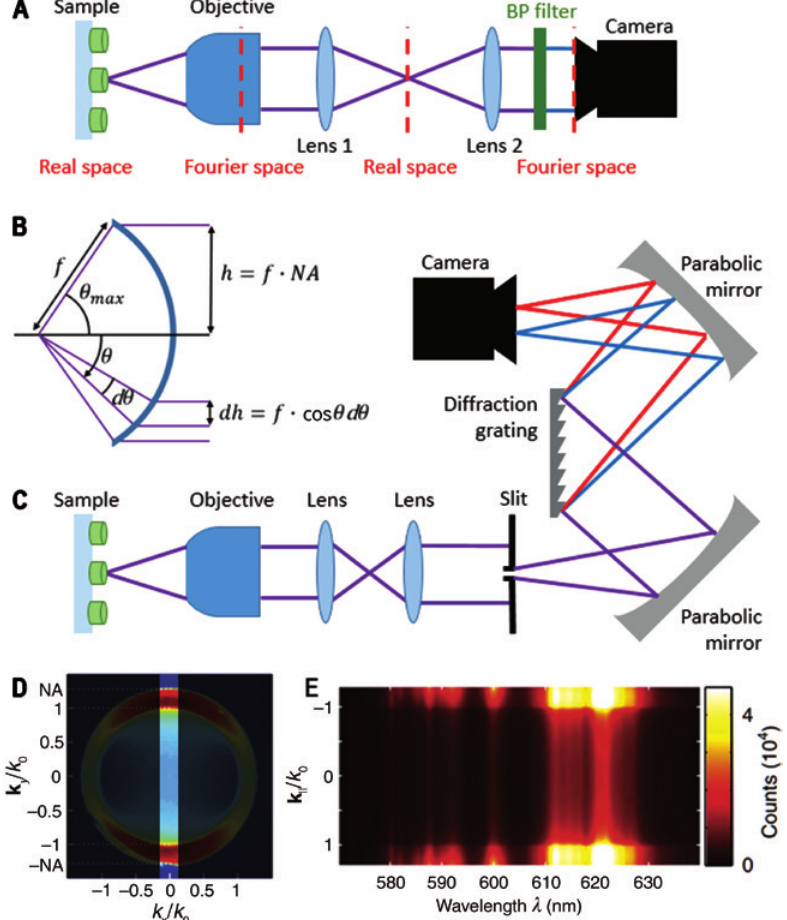
Figure 12: Fourier imaging. (A) Schematic of a typical Fourier imaging system. The objective collects the emission from the sample and forms the Fourier image of the emission at its back focal plane. The front focal plane of lens 1 is placed at the back focal plane of the objective. Lens 1 forms the real space image at its back focal plane. Lens 2 has its front focal plane at the back focal plane of lens 1 and forms the Fouirer space image at the camera. The bandpass (BP) filter is used to select the spectral region of interest. (B) Schematic of the projection of the angular emission by the objective onto the back focal plane. Adapted from [127]. (C) Schematic of the momentum-resolved spectroscopy system. (D) The back focal plane of the objective is imaged at the entrance slit of the spectrometer. (E) Example of the momentum-resolved spectroscopy image. The illustrations in (D) and (E) are reprinted by permission of the Springer Nature, from: Springer Nature, Nature Communications, Quantifying the magnetic nature of light emission, Taminiau et al. [128], Copyright